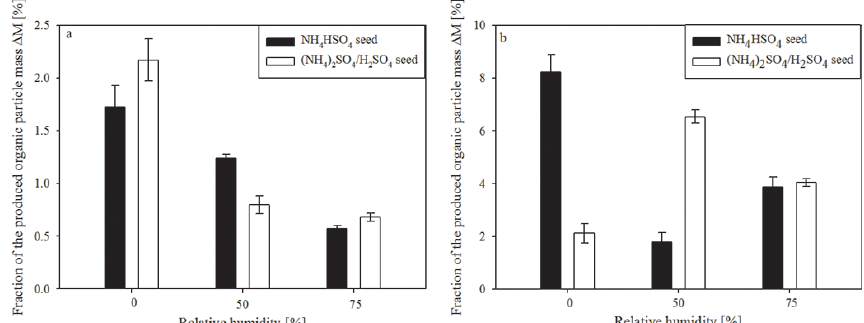
Figure 5. Contribution of methylglyoxal (a) and their heat-decomposable oligomers (b) to the produced organic particle mass ( (cid:49) M) with NH 4 HSO 4 and (NH 4 ) 2 SO 4 /H 2 SO 4 seed particles under variation in the relative